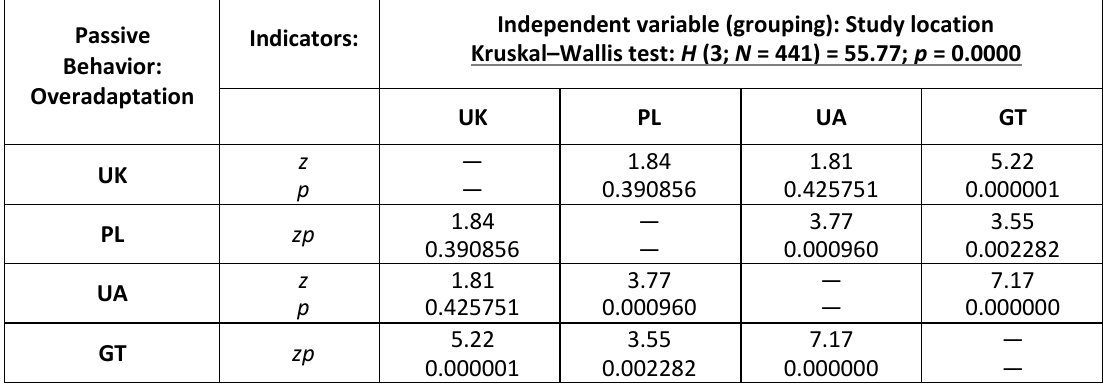
Notably, overadaptation is often convenient for the individual’s environment and is therefore socially